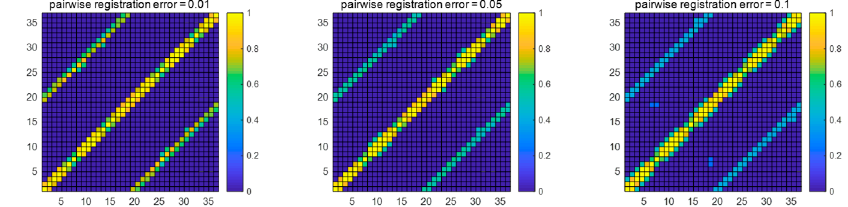
Figure 5. The weight matrixes under three different pairwise registration